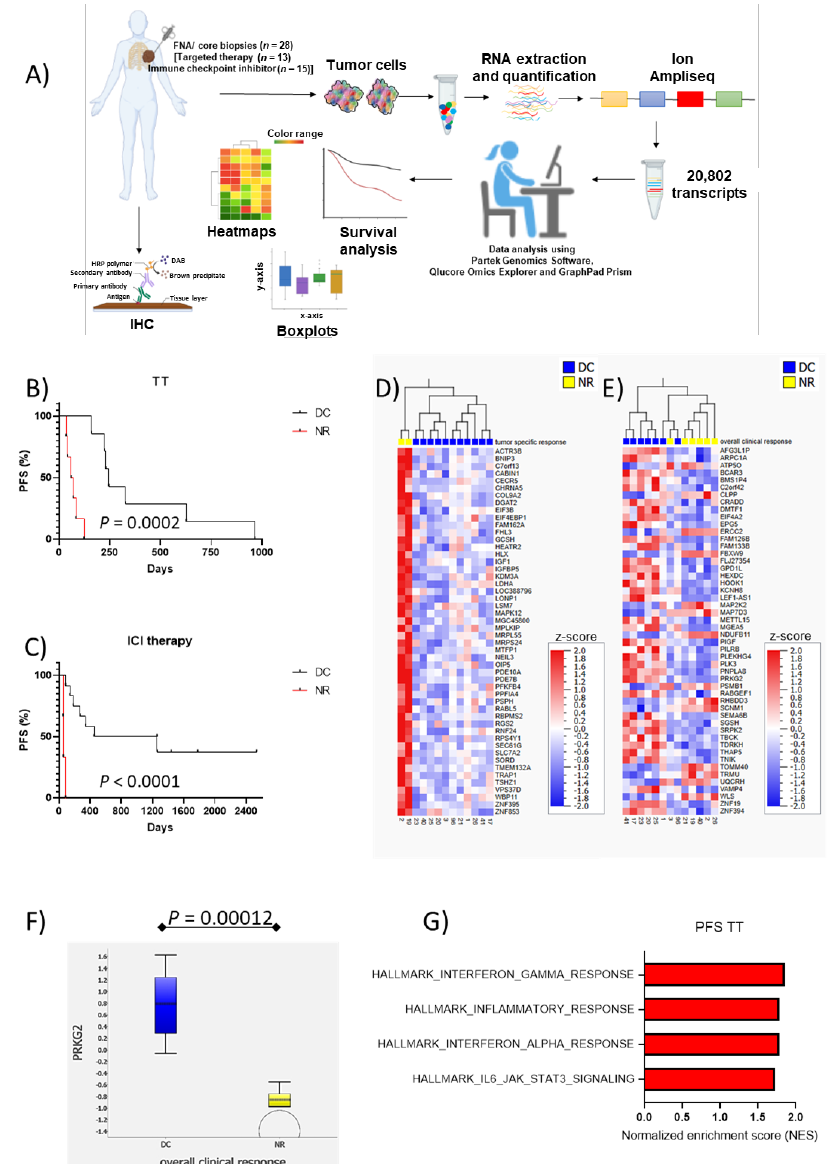
Figure 1. Inflammatory and IFN- γ response signatures are associated with PFS in patients treated with targeted therapy (TT). ( A ) A flow chart of the study design. Fine needle aspirate (FNA) or core biopsy samples and clinical data were collected from 28 Stage IV cutaneous malignant melanoma (CMM) patients before treatment with TT or immune checkpoint inhibitor (ICI) therapy. RNA from tumor samples were analyzed by targeted sequencing using Ion AmpliSeq™. This data has then been used to assess the relationship between RNA expression levels and patient outcome, progression-free survival, and treatment response (tumor-specific and overall clinical) in patients treated with either TT or ICI. Finally, one of the candidates was validated using immunohistochemistry on an independent cohort. The flow chart was created with BioRender.com (last accessed on 7 July 2022). ( B , C ) Kaplan– Meier curves demonstrate progression free survival (PFS) for patients with disease control (DC) and non-responder (NR) to TT and ICI, respectively. ( D ) Heatmap for hierarchal clustering of the top 50 differentially expressed genes between tumor-specific DC and NR to TT. ( E ) Heatmap for hierarchal clustering of the top 50 differentially expressed genes between overall clinical DC and NR to TT. ( F ) Box plot showing expression of PRKG2 in patients with DC and NR to TT (Tukey’s range t -test). ( G ): Gene set enrichment analysis (GSEA) showed significantly enriched immune gene sets in relation to PFS after TT (FDR <